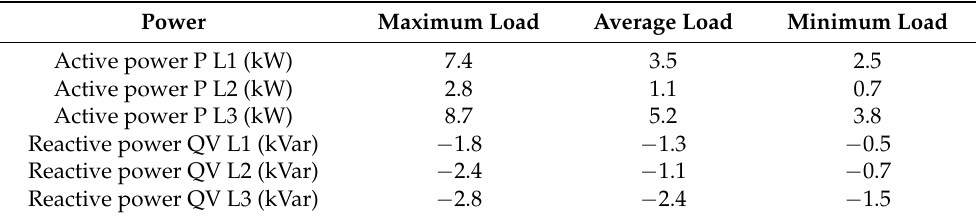
Table 4. Active and reactive power consumption for individual phases.